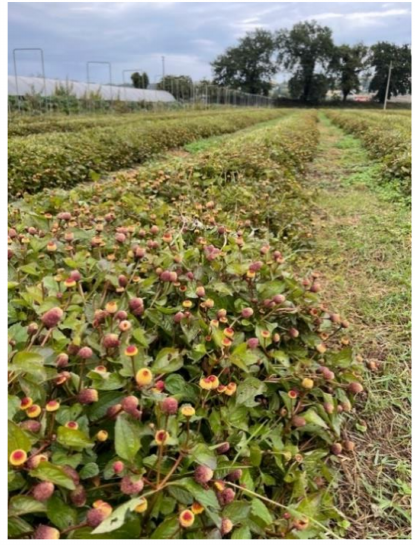
Figure 2. A. oleracea field